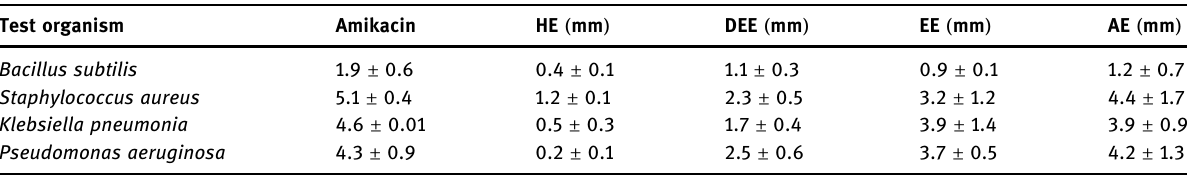
Table 2: Antibacterial activity ( mm ) of crude R. mucronata leaf extract Test